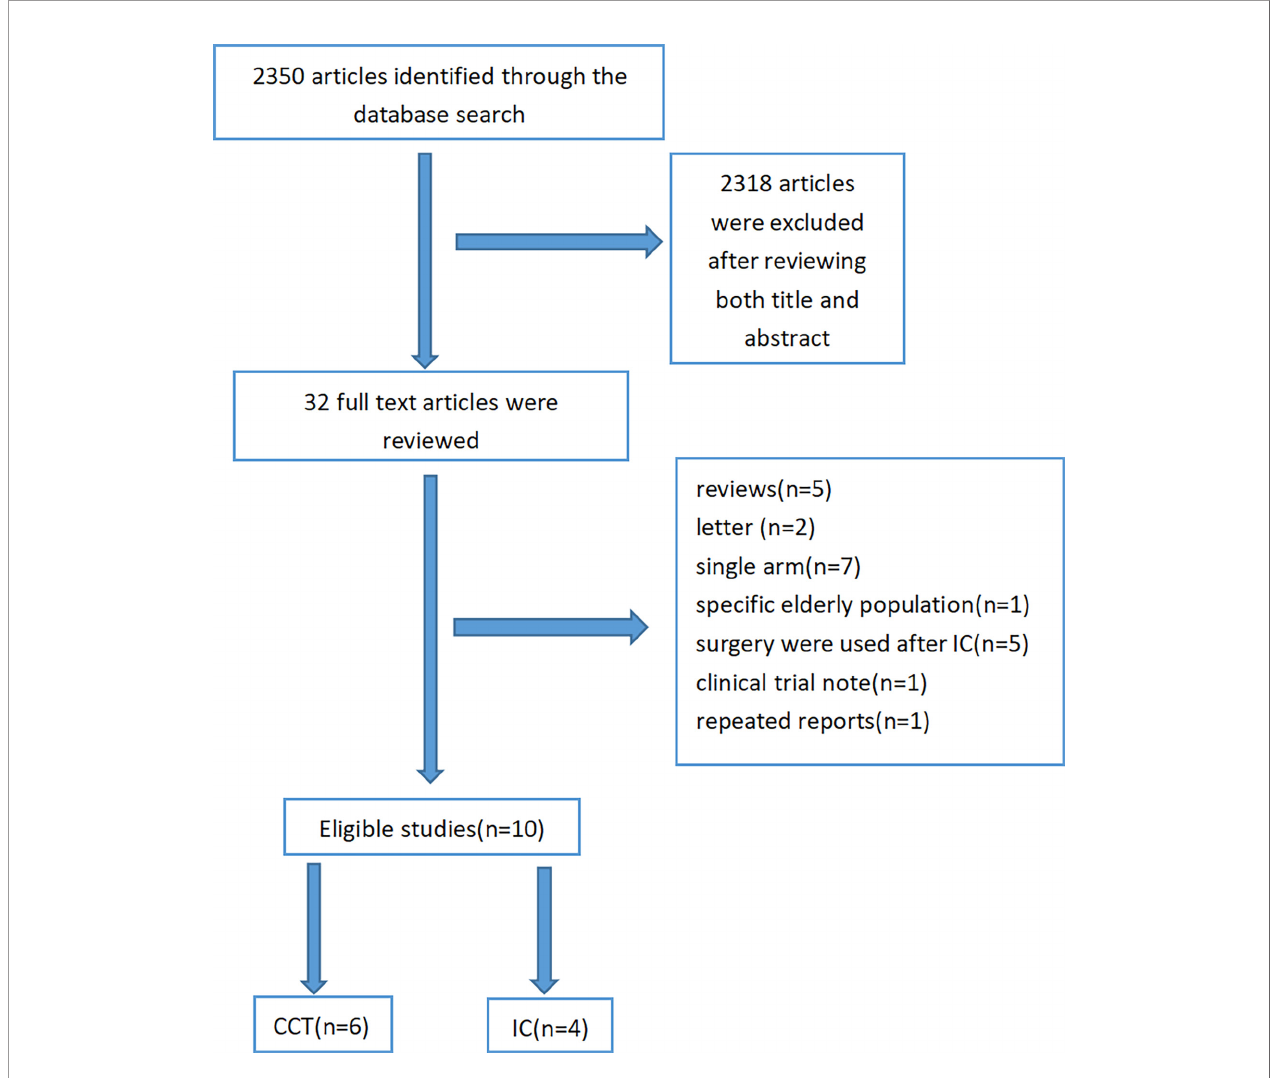
FIGURE 1 | Study selection process.